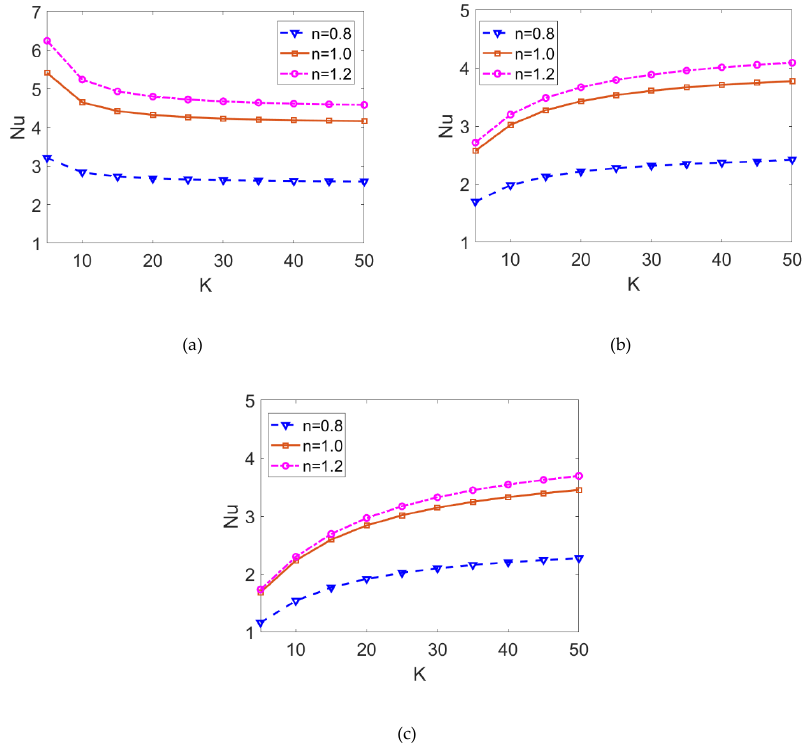
Figure 8. The variation of Nusselt number with the electrokinetic width K for shear thinning nanofluid, Newtonian nanofluid, shear thickening nanofluid when the Joule heating parameters are given as ( a ) S = −5; ( b ) S = 0; ( c ) S = 5.